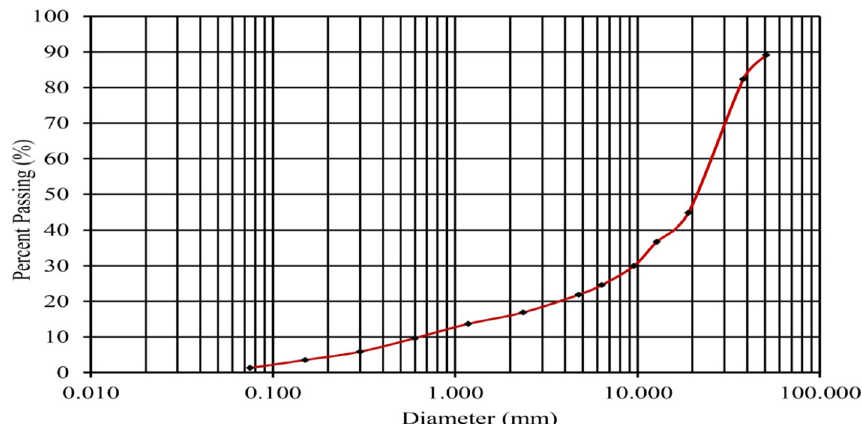
Fig. 2 Particle-size distribution curve of the study reach (Yasuj regional water company, Minis- try of Energy)